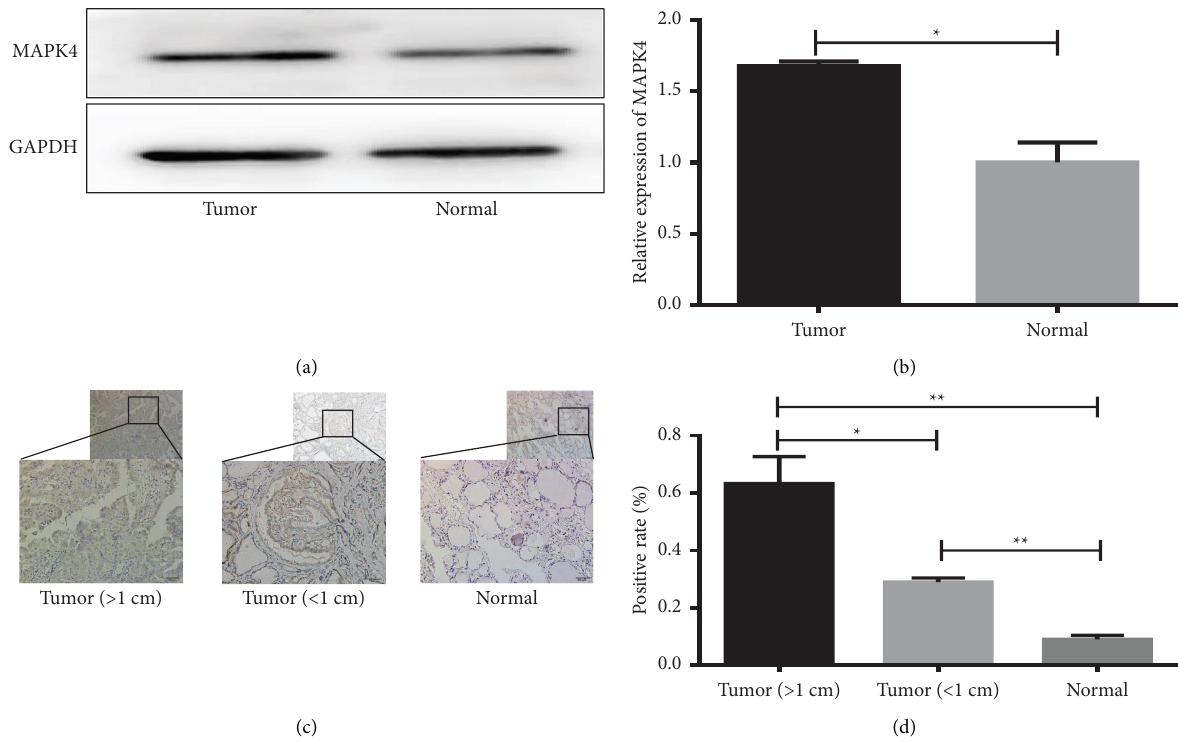
Figure 4: Te expression level of MAPK4 in PTC was signifcantly higher than that in normal thyroid tissue. (a–d) Expression of MAPK4 in PTC and normal thyroid tissue by western blotting and immunohistochemistry. ∗ P < 0 . 05 ; ∗∗ P < 0 .